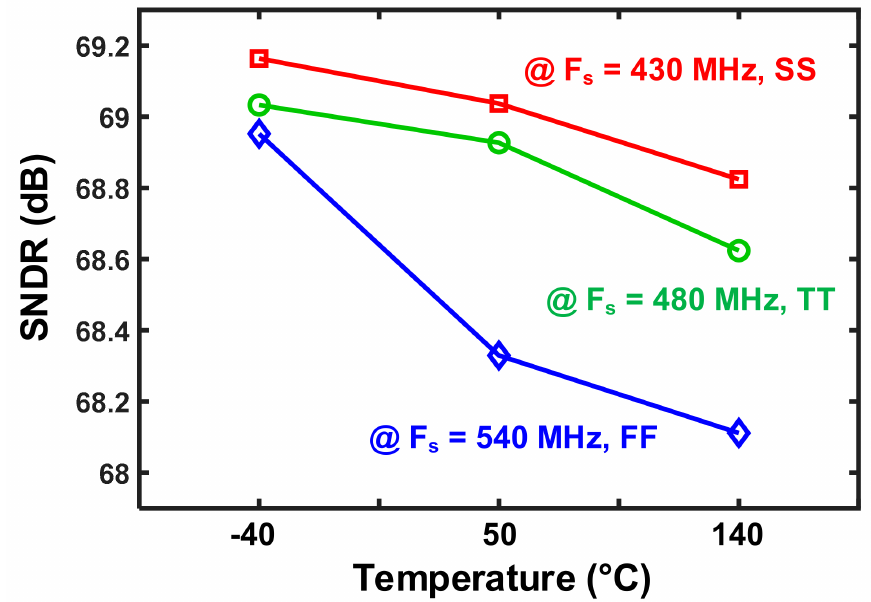
Figure 14. Simulated SNDR versus temperature under different process